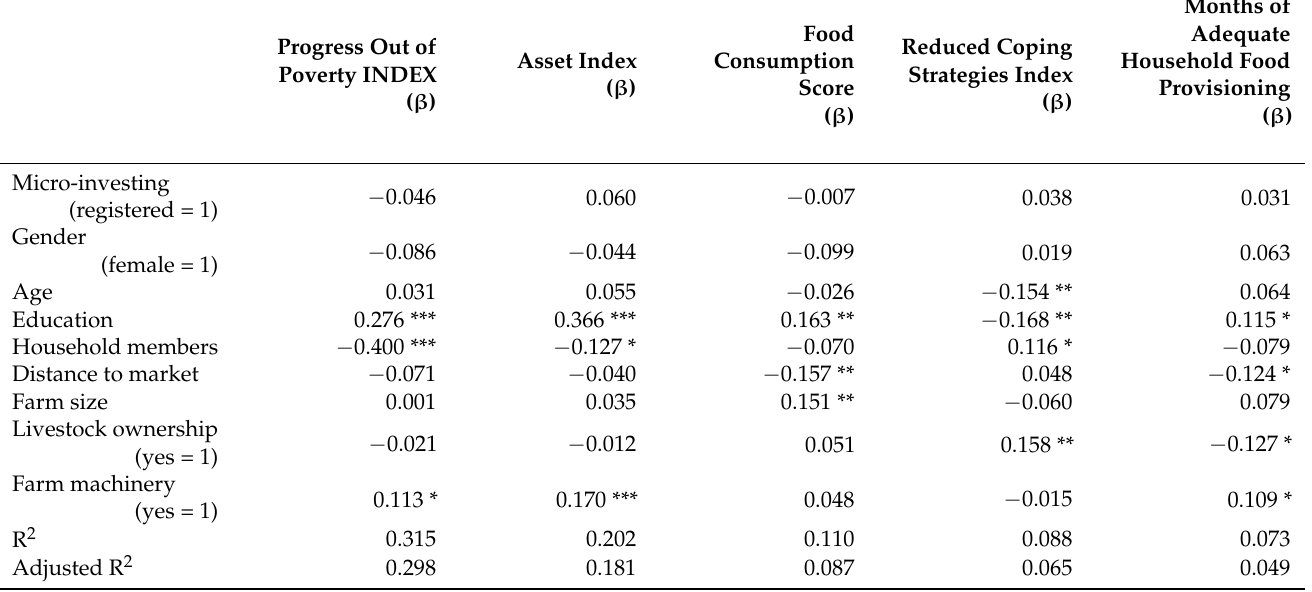
Table 7. The impact of MI program participation as a determinant of poverty over all study